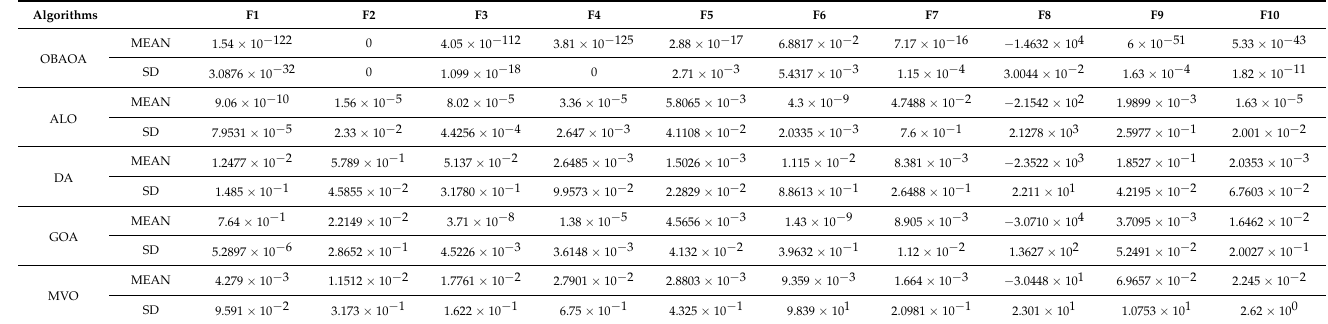
Table 2. Statistical results of benchmark test